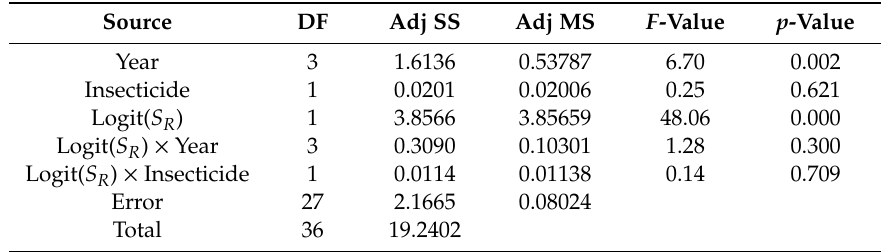
Table 3. Analysis of Variance table for log odds of survival in the field against log odds of combined survival in rearing, year, and insecticide treatment (Equation (4)).